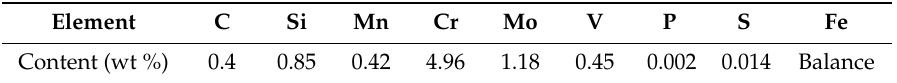
Table 1. The chemical composition of AISI H11 steel.